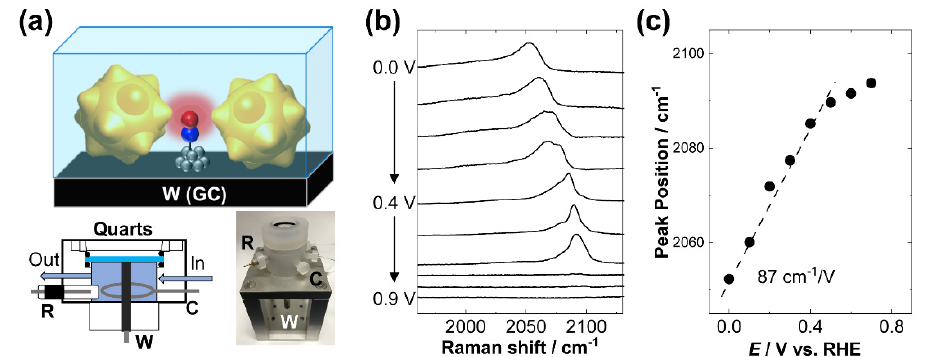
Figure 5. In situ Raman study of CO adsorbed on Pt islands with shell-isolated Au nanostars: ( a ) schematics of in situ shell-isolated nanostar enhanced Raman spectroscopy and the homemade cell. ( b ) Electrode potential-dependent steady-state SHINER spectra for CO adsorbed on Pt islands (0.9 nm in diameter) in CO-saturated 0.1 M HClO 4 , and ( c ) potential dependent Raman peak frequency shifts of the CO stretching mode. The Stark tuning rate was 87 cm − 1 /V.